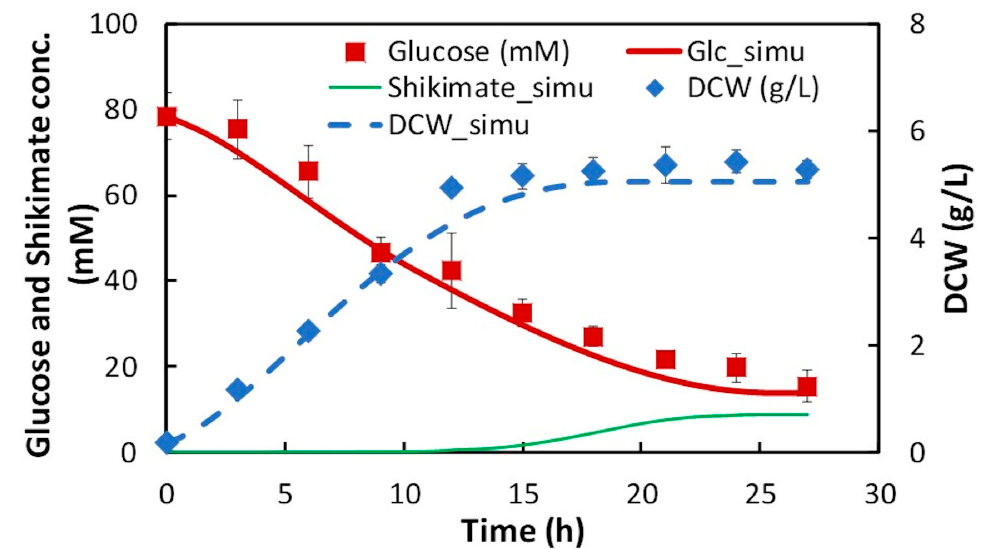
Figure 4. Comparison of time-course data on concentrations of glucose, dry cell weight (DCW), and shikimic acid obtained by dynamic flux balance analysis (FBA) (dFBA) to experimental values. Symbols (square: glucose, rhombus: dry cell weight) and lines (bold: glucose, dashed: DCW, solid: shikimic acid) indicate the values obtained by the experiment and simulation, respectively.